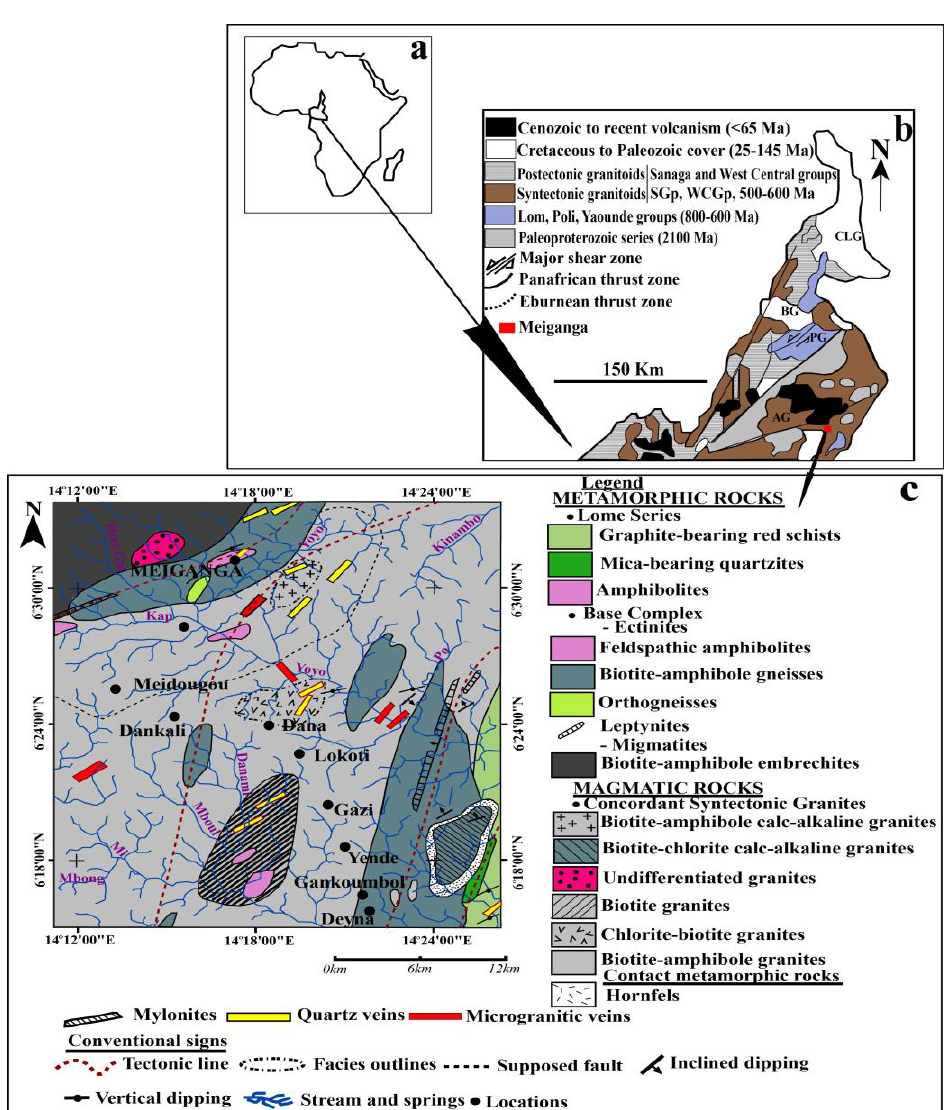
Figure 1. Geological sketch map of regional and local settings; ( a ) Cameroon in Africa, ( b ) geologic map of Adamawa, North and Far North Cameroon with the location of the south of Meiganga and ( c ) geological map of the south of Meiganga with the sample